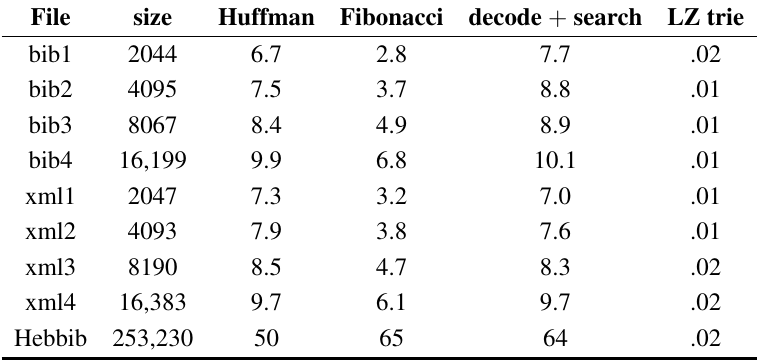
Table 5. Empirical comparison of processing